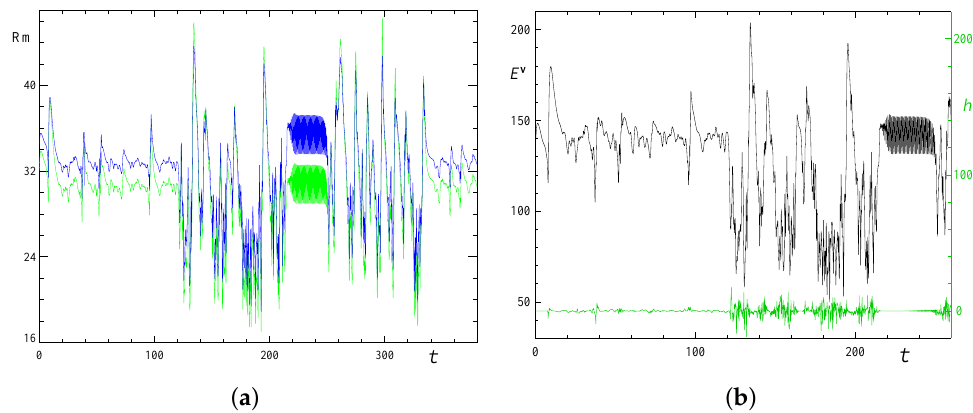
Figure 22. Temporal behaviour of the magnetic Reynolds number estimates, Rm (cid:48) Rm (cid:48) (blue line), (a); and of the kinetic helicity (green line, right vertical axis) together with the kinetic 3 energy (black line, left vertical axis) for reference, (b), in run 4 x